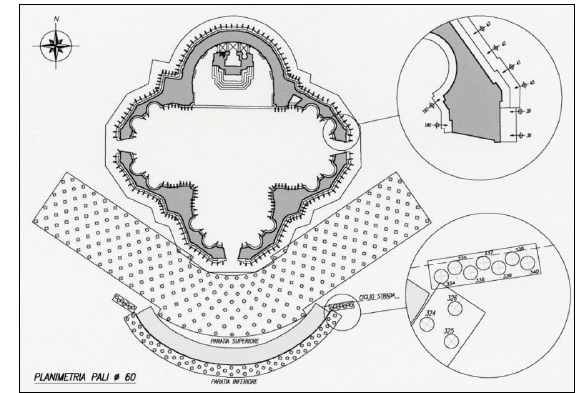
Figure 4. Recent interventions (Mariani, 2006 and 2008)